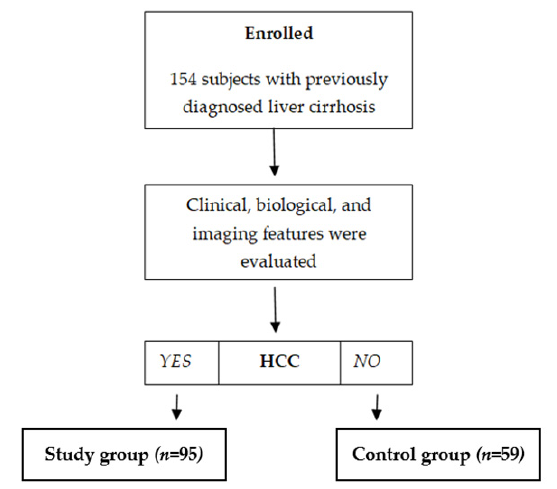
Figure 1. Enrollment of subjects.